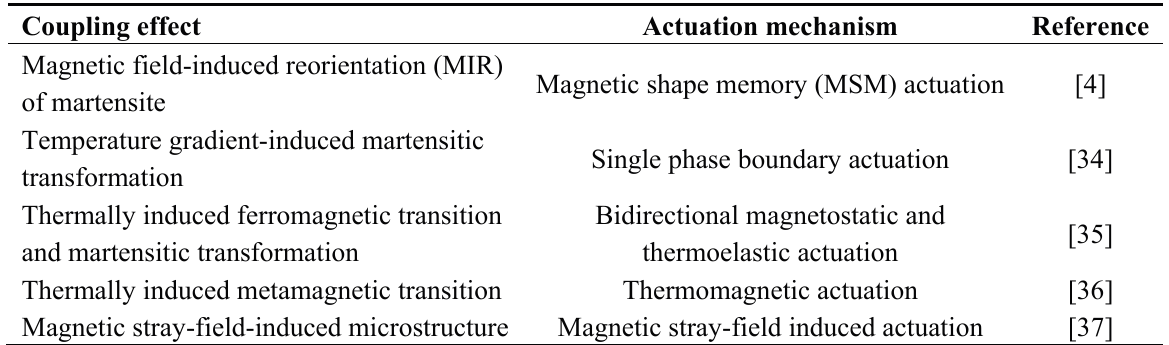
Table 2. Mechanisms for magnetic shape memory actuation and underlying coupling